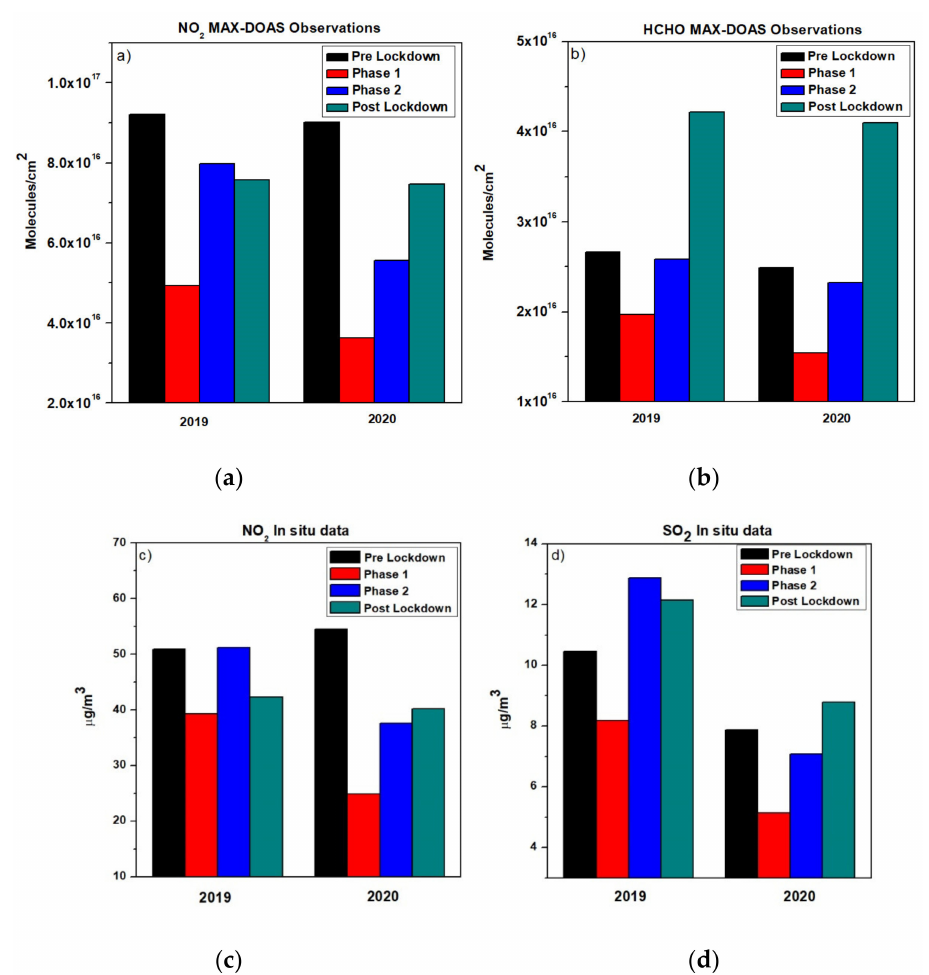
Figure 6. Comparison of ( a ) NO 2 (MAX-DOAS), ( b ) SO 2 , ( c ) NO 2 (In-situ) and ( d ) HCHO mean concentrations during di ff erent phases in 2019 and 2020.